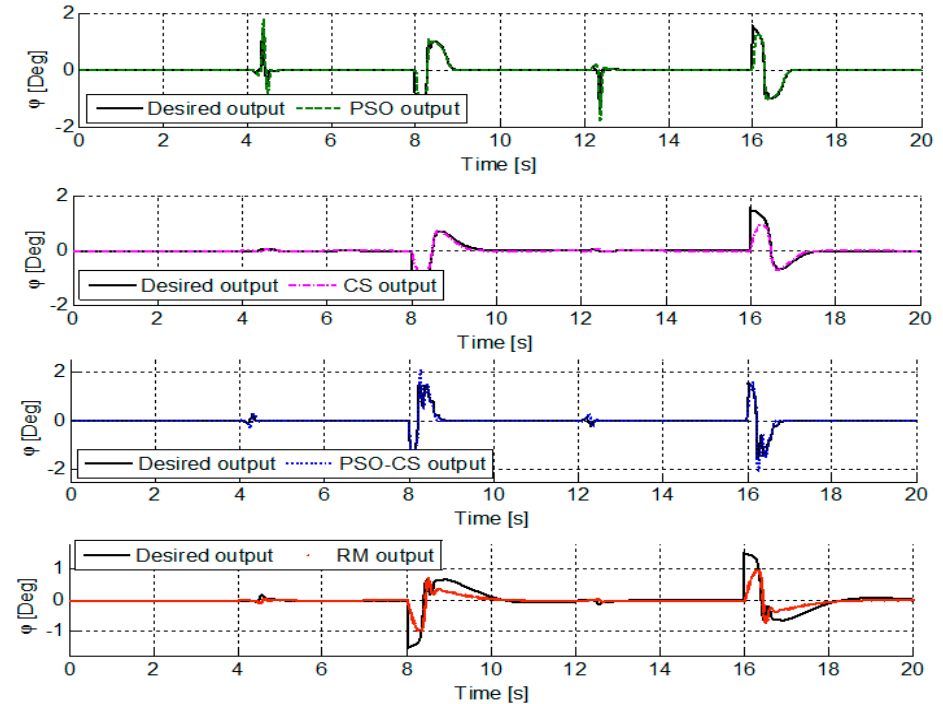
Figure 10. Quadrotor’s roll attitude ( ϕ ) using Particle Swarm Optimization (PSO), Cuckoo Search (CS), Particle Swarm Optimization-Cuckoo Search (PSO-CS), and Reference Model (RM) (rectangular trajectory).